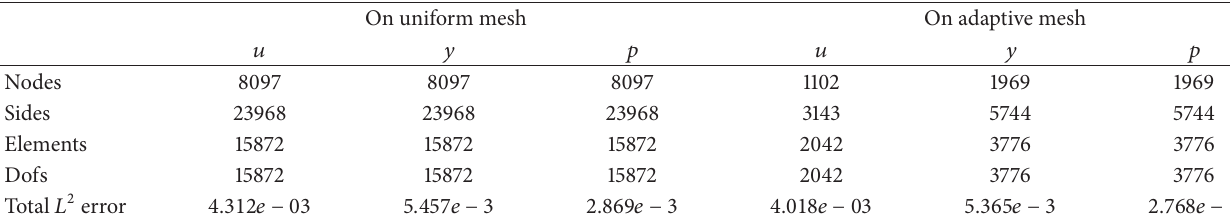
Table 1: Numerical results on uniform and adaptive meshes. On uniform mesh On adaptive